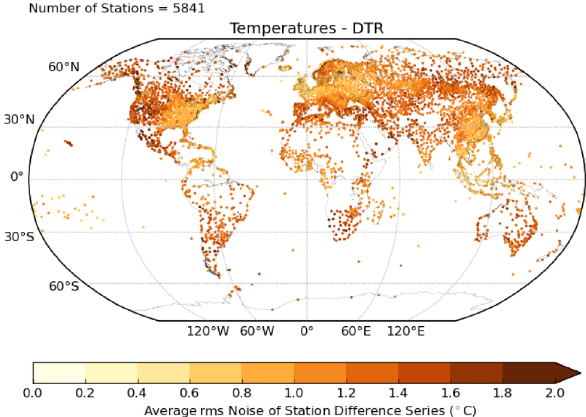
Figure A2. The average rms difference for the neighbours from each station for the monthly-average diurnal temperature